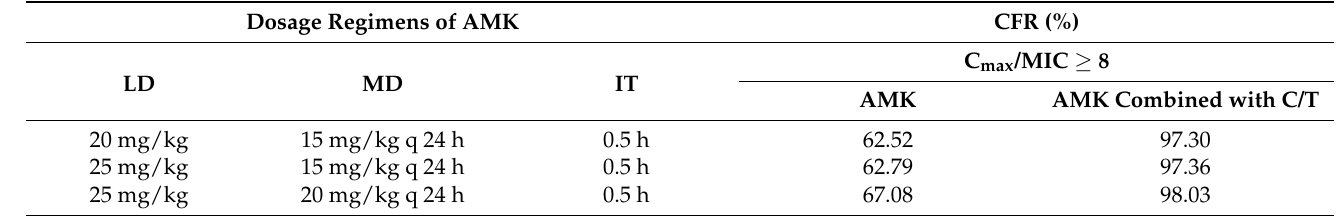
Table 7. The cumulative fraction of response (CFR) for each dosing regimen of amikacin (AMK) and amikacin (AMK) combined with ceftolozane/tazobactam